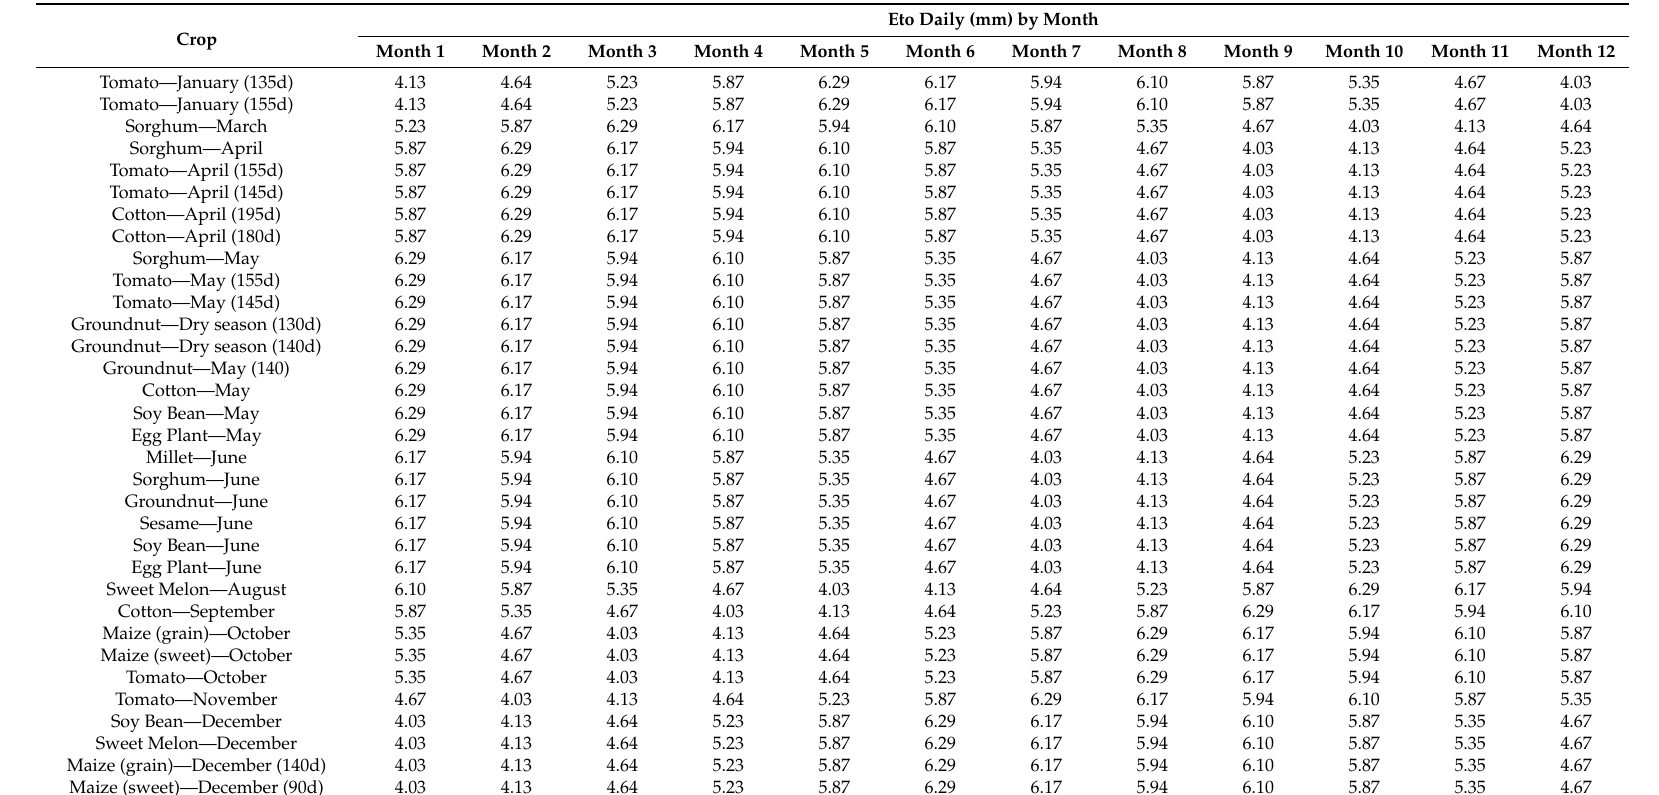
Table A3. Crop daily evapotranspiration by